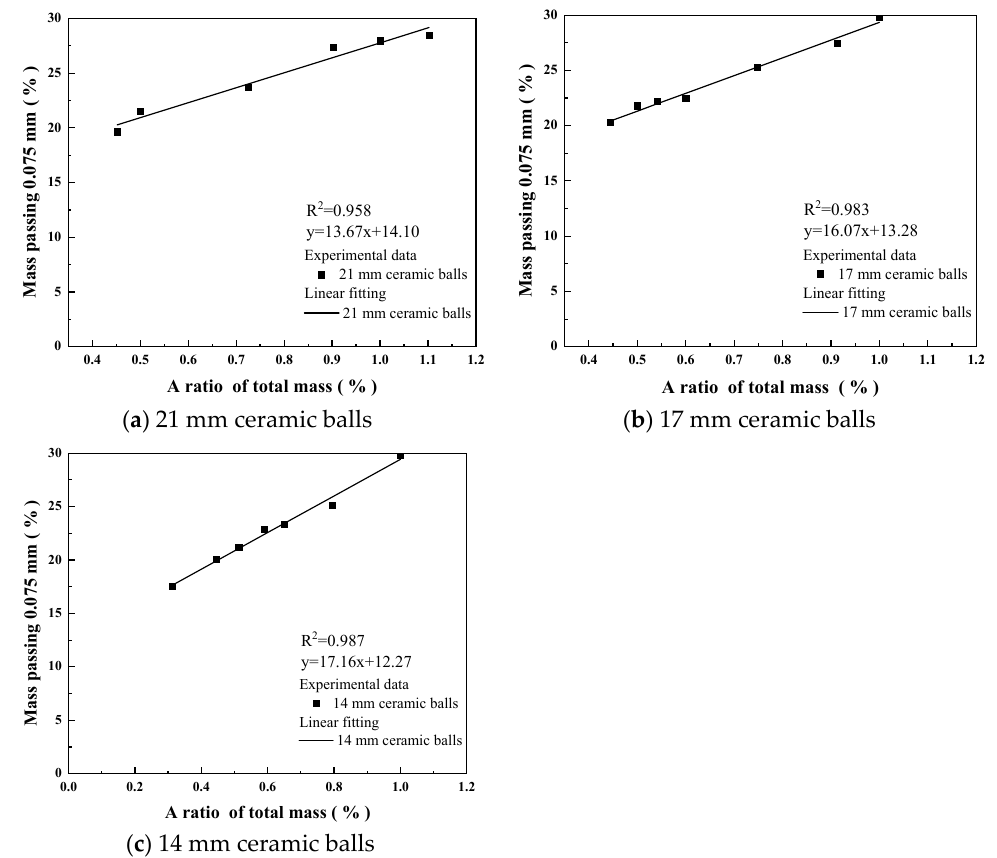
Figure 10. The relationship of the distribution of the percentage passing 0.075 mm in the ground product and the ratio of the total mass of 12 × 12 mm cylpebs at the same charge volume.